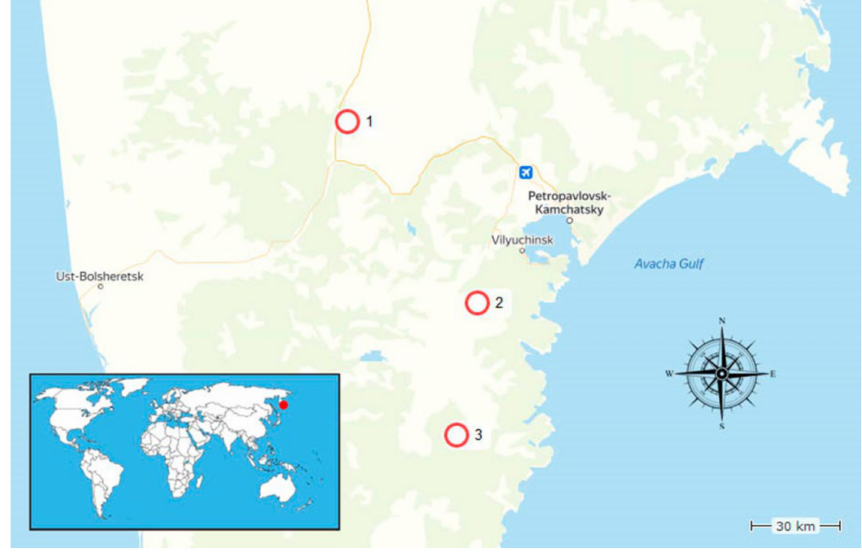
Figure 1. Study area. Red dot indicate the Kamchatka peninsula and red circles indicate the springs investigated. Area 1—Malki thermal springs (sites 1–2); Area 2—Upper Paratunka thermal springs (sites 3–5); Area 3—Dachnie thermal springs (sites